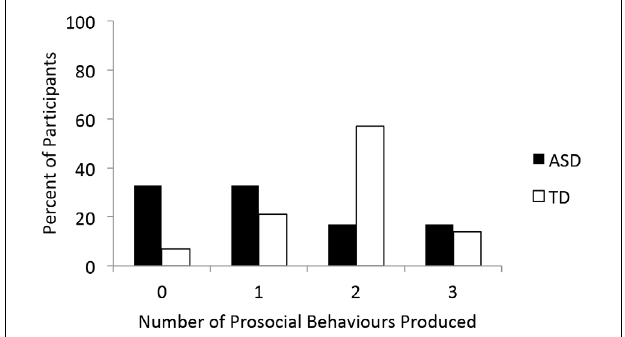
FIGURE 3 | Number of prosocial behaviors produced (out of three) by